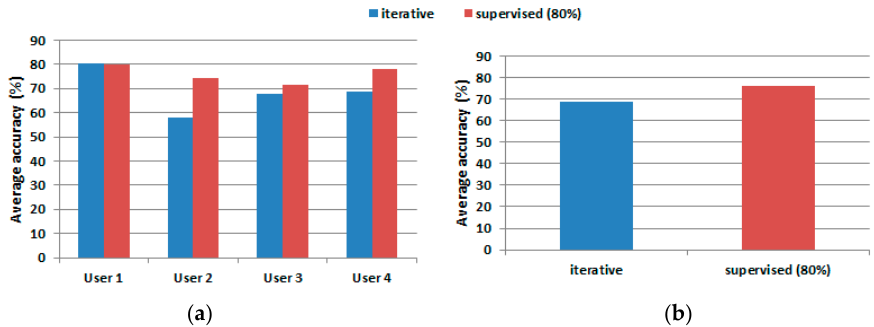
Figure 6. Accuracy comparison: ( a ) accuracy generated by SVM multi-class classifier on each user; and ( b ) average accuracy for iterative versus supervised methods.